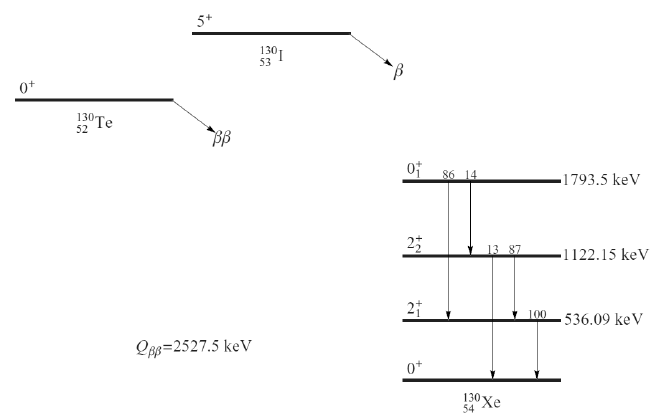
Figure 14. Scheme of 2 β − decay of 130 Te to the ground state and to the first excited levels of 130 Te (reprinted from Reference [72] under the terms of the Creative Commons Attribution 4.0 licence). The energies of the levels and the relative main branching ratios are taken from Reference